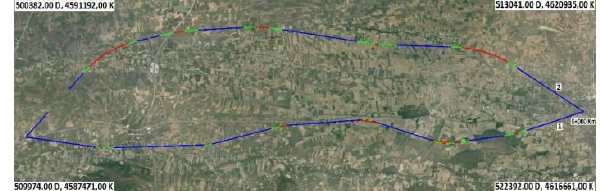
Figure 1. Routes for the existing and improved conventional lines for Implementation 1